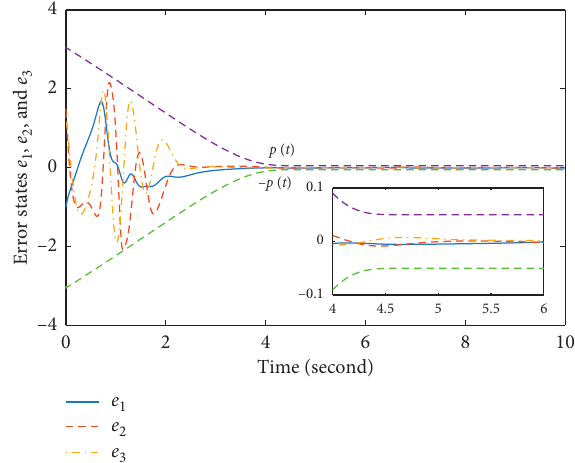
, e , and e at 1 2 3